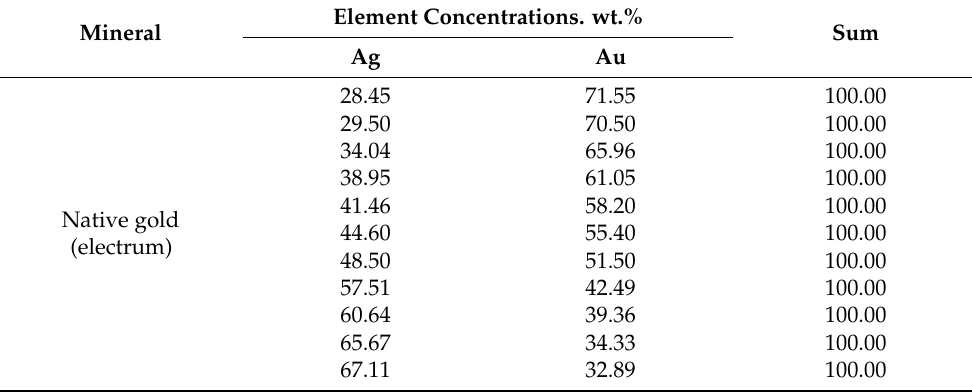
Table 4. Compositions of native gold in the Corrida ores.